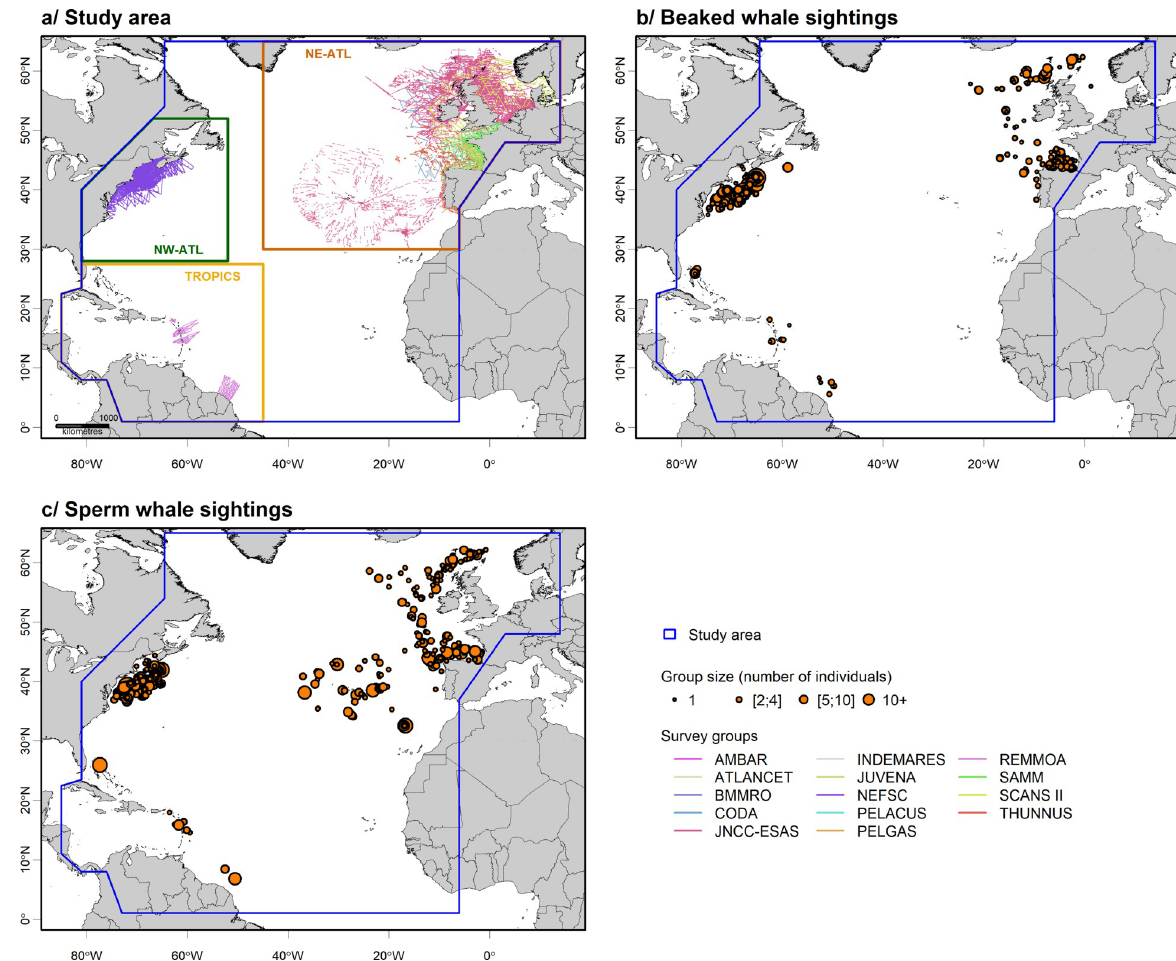
Fig 1. Study area divided into sub-regions showing assembled survey effort (a), along with beaked whale (b) and sperm whale (c) sightings recorded during all surveys. The blue polygon delineates overall study area and other polygons delineate sub-regions. Surveys were carried out along transects following a line-transect methodology (survey details in S1 Table in S1 Appendix). Sightings were classified by group sizes with each point representing one group of individuals and point size representing the number of animals in a group. Base map from https://www.gebco.